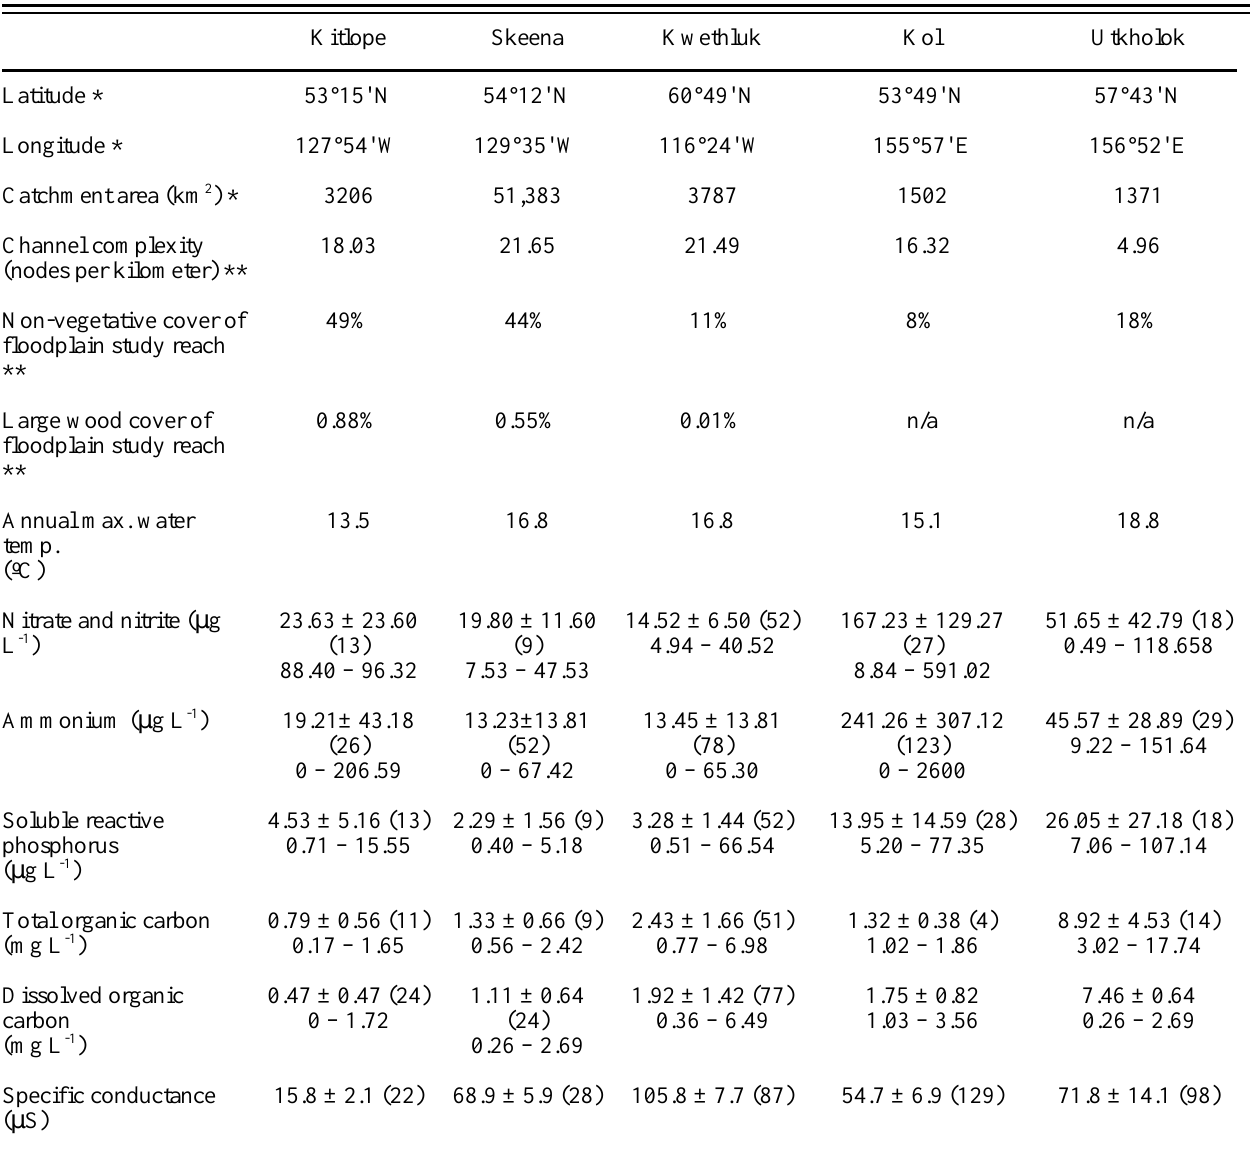
Table 2 . Measures of habitat complexity, water quality, fish density, and marine-derived nutrients among five pan-Pacific Rim sites in the Salmonid Rivers Observatory Network (SaRON). Water chemistry values are means ± standard deviation, with range below. Bracketed values are sample sizes. Fish and water quality data are from main channel shallow shoreline sites only. Vegetation species/types sampled: Co = cottonwood ( Populus spp.); W = willow ( Salix spp.); D = red osier dogwood ( Cornus sericea ); F = Filipendula kamtschatica ; Bl = Arctic blackberry ( Rubus arcticus ); Bi = paper birch ( Betula papyrifera ); G = grass (Poaceae); Sa = salmonberry ( Rubus spectabilis ); E = elderberry ( Sambucus spp.); Se = Senecio cannabifolius ; Ch = Chosenia arbutifolia ; N = stinging nettle ( Urtica dioica ). All data are from SaRON 2004–2006 except for Skeena River (data from 2005–2006) and * Riverscape Analysis Project (2010); ** Quickbird floodplain imagery (Lorang et al.